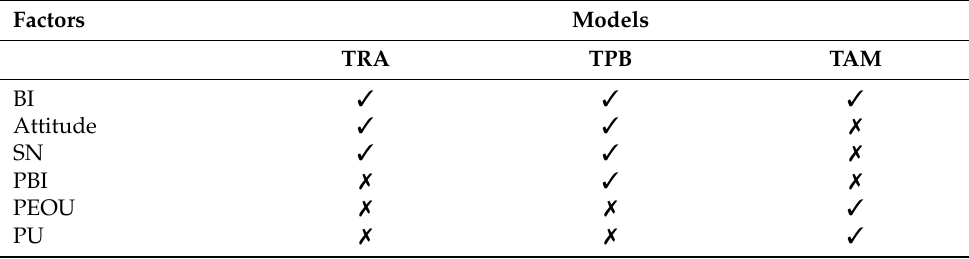
Table 1. Factors of TRA, TPB, and